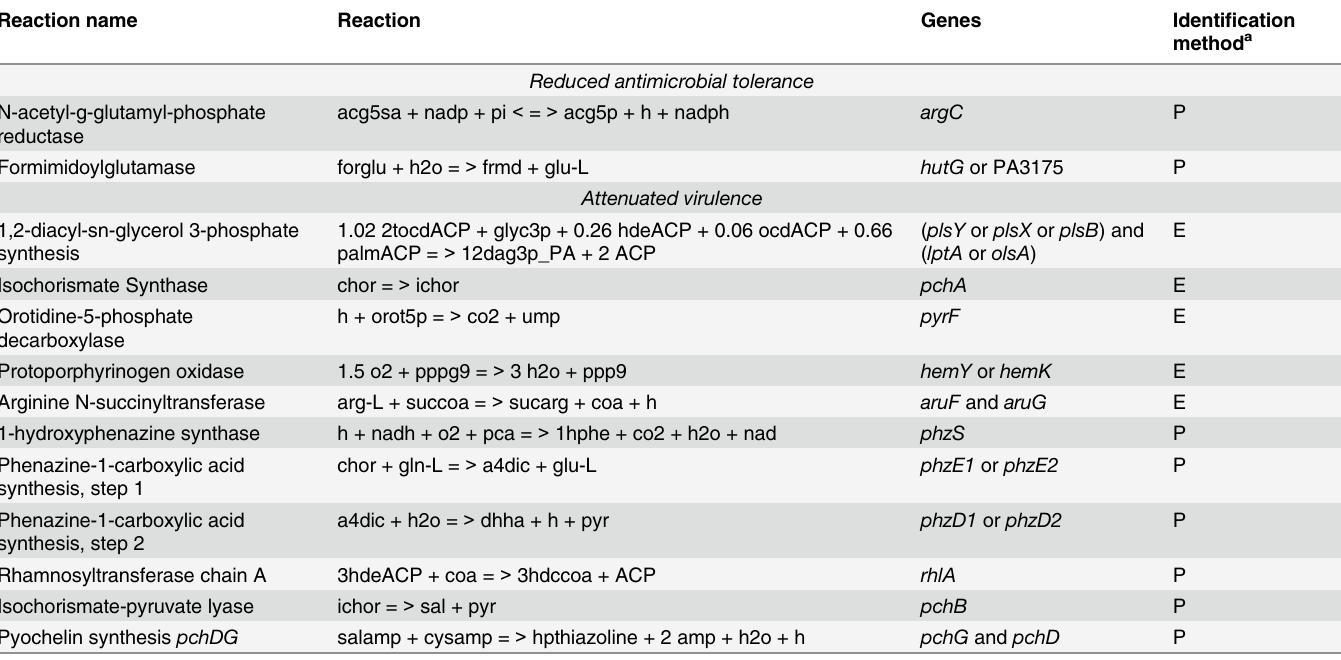
Table 1. Putative target reactions against biofilm that also would decrease antimicrobial tolerance or attenuate virulence. Reaction